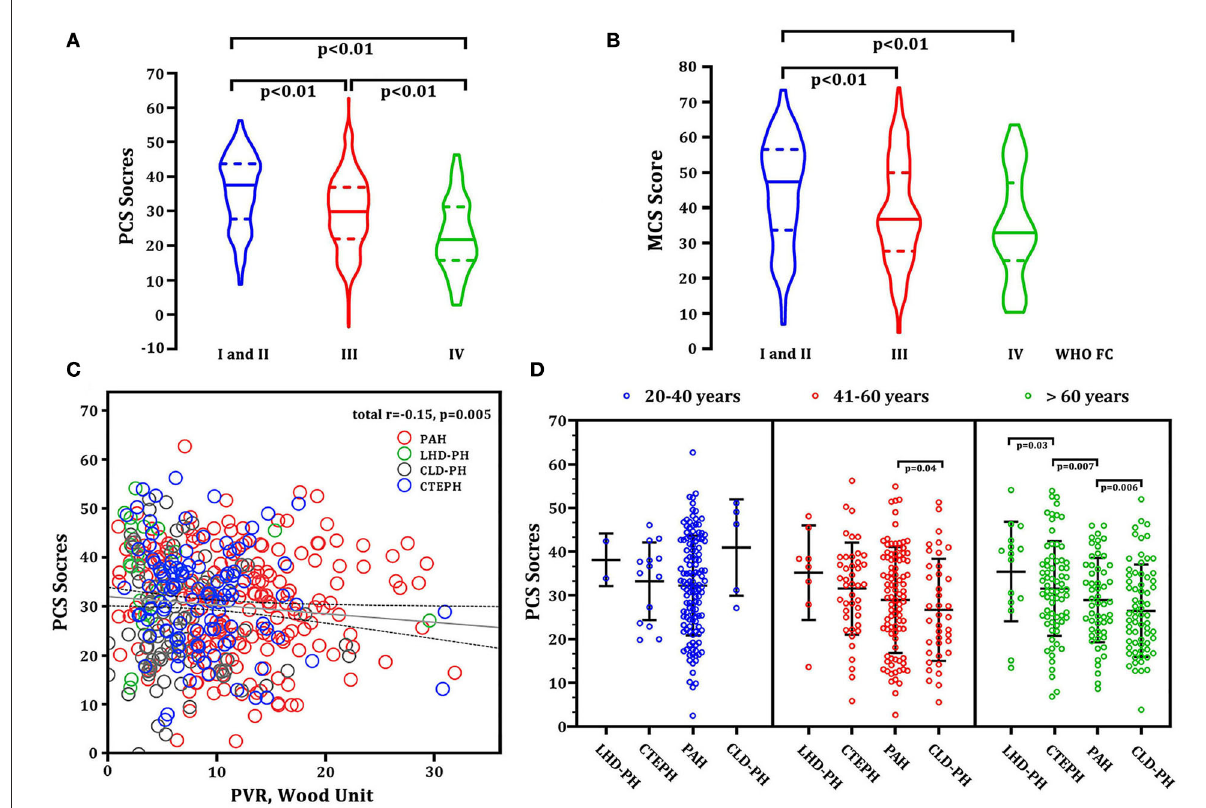
FIGURE4 Correlations between baseline HRQOL and demographics and PVR. (A) PCS score vs. WHO FC severity; (B) MCS score vs. WHO FC severity; (C) PCS score vs. PVR (linear model: r 2 = 0.15, p = 0.005). Red circles represent patients with PAH. Green circles represent the patients with LHD-PH. Gray circles represent CLD-PH. Blue circles represent CTEPH. (D) PCS scores at different ages and in different disease types. CLD-PH, pulmonary hypertension due to lung disease and/or hypoxia; CTEPH, chronic thromboembolic pulmonary hypertension; LHD-PH, pulmonary hypertension due to left heart disease; MCS, mental component summary; PAH, pulmonary arterial hypertension; PCS, physical component summary; PVR, pulmonary vascular resistance; WHO FC, World Health Organization functional